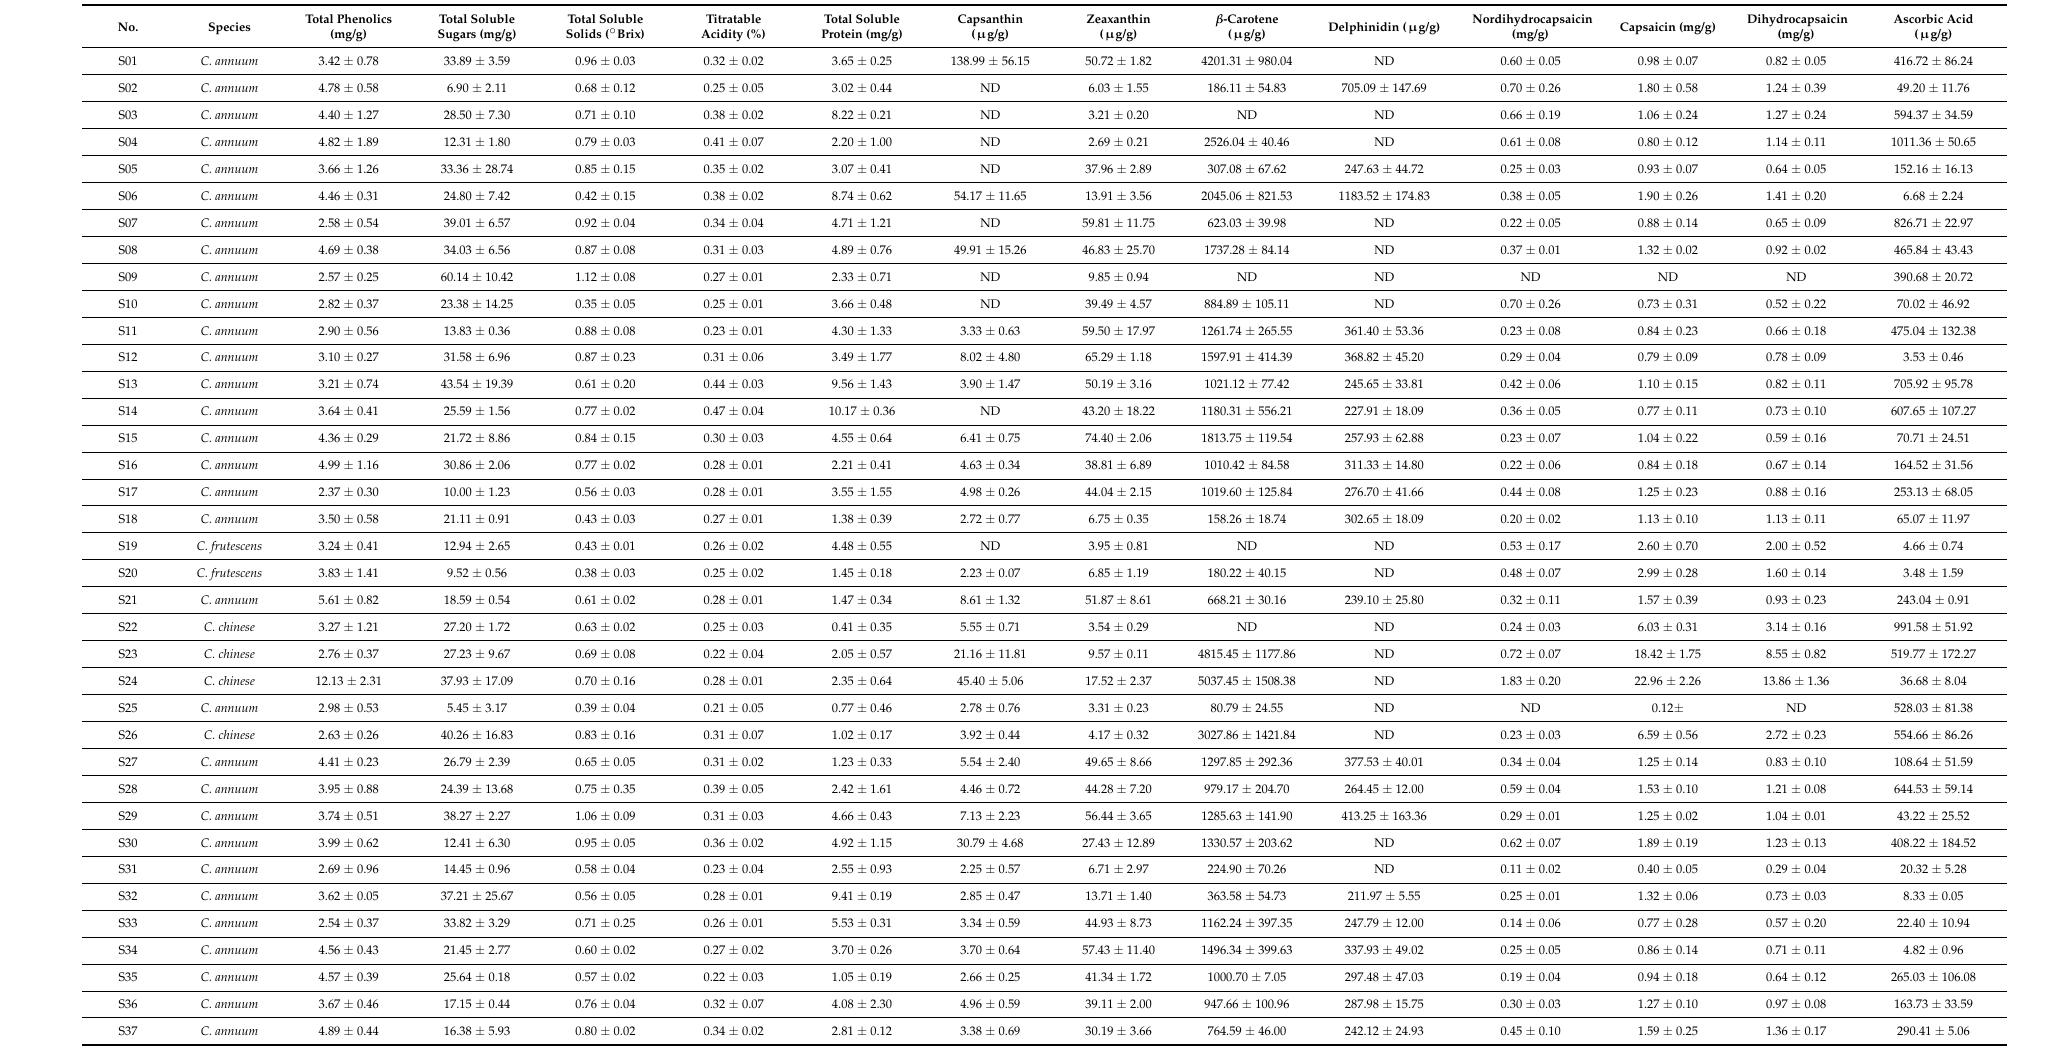
Table 1. Concentrations of fruit metabolites among 75 pepper germplasm